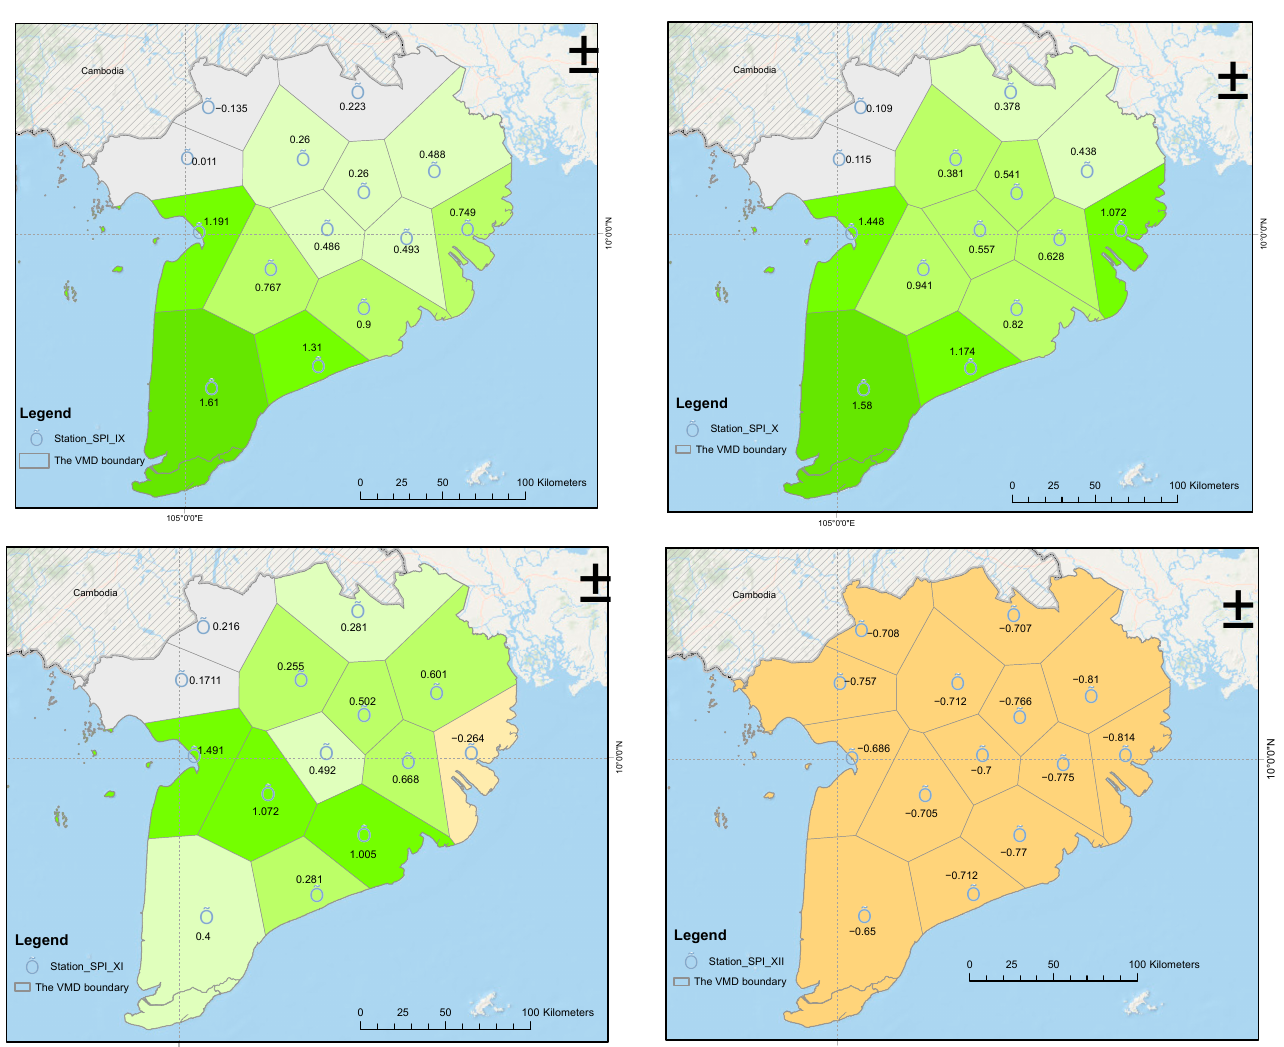
Figure 5. The mean SPI 1-month drought for the VMD using Thiessen polygon interpolation, during 1980 and 2019.